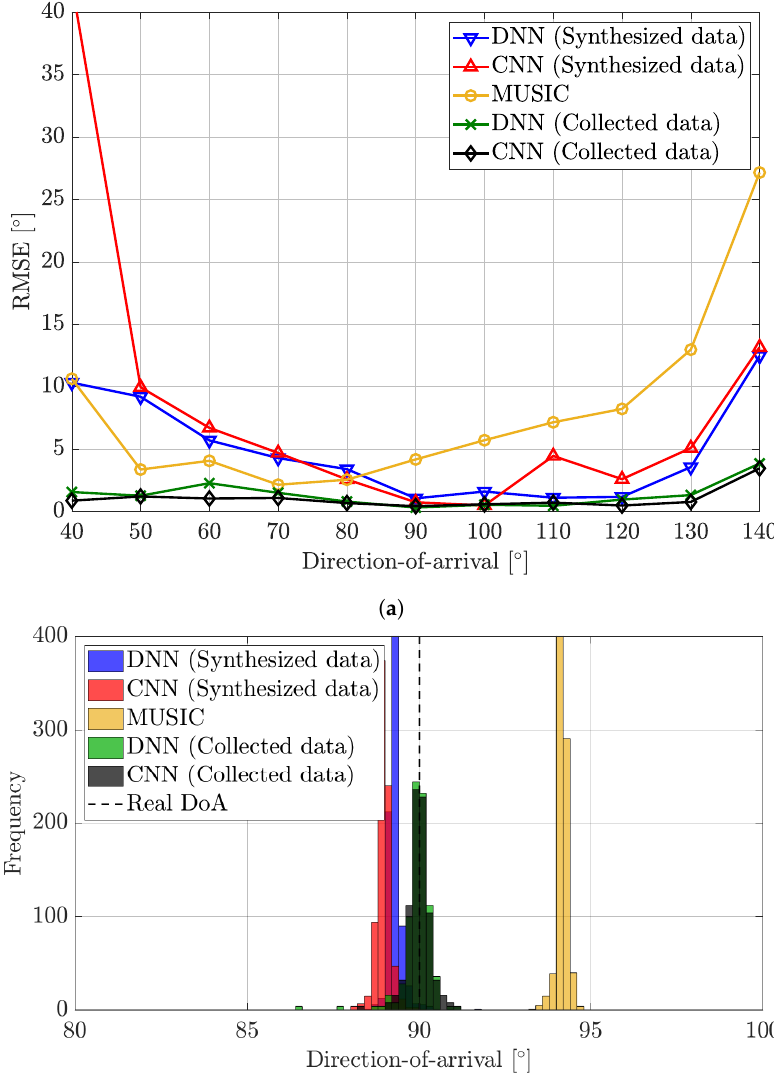
Figure 6. Performance analysis of DoA estimation algorithms in the outdoor environment. The first figure shows the RMSE according to DoA, and the second figure is a histogram of estimation results when the actual DoA is 90 ◦ . ( a ) RMSE. ( b ) Histogram.